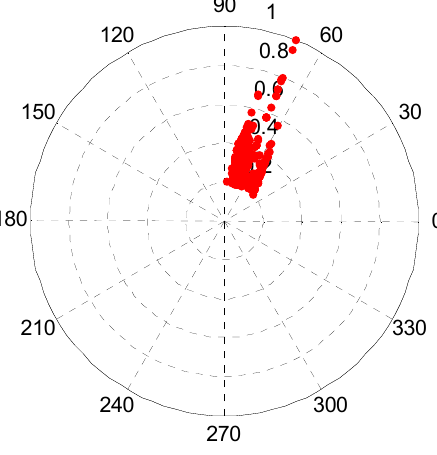
Figure 4. The polar plot of the scatter diagram about the mixed signals.